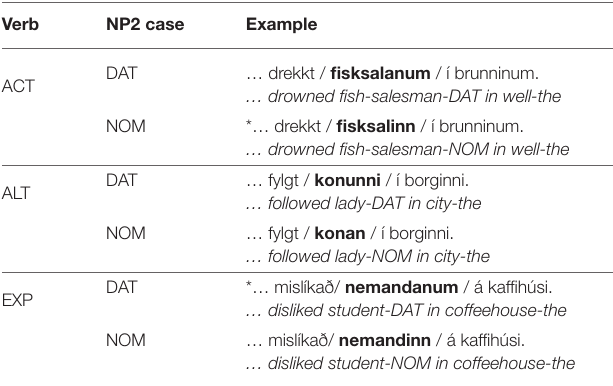
TABLE 1 | Example sentences for the present study. Verb NP2 case